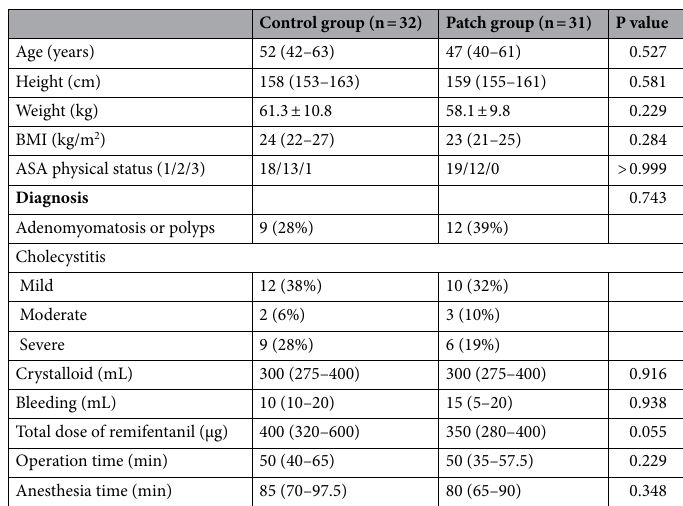
Table 1. Patient’s characteristics and operation details. Values are presented as mean ± standard deviation, median (interquartile range) or number (proportion). BMI body mass index, ASA American Society of Anesthesiologists.